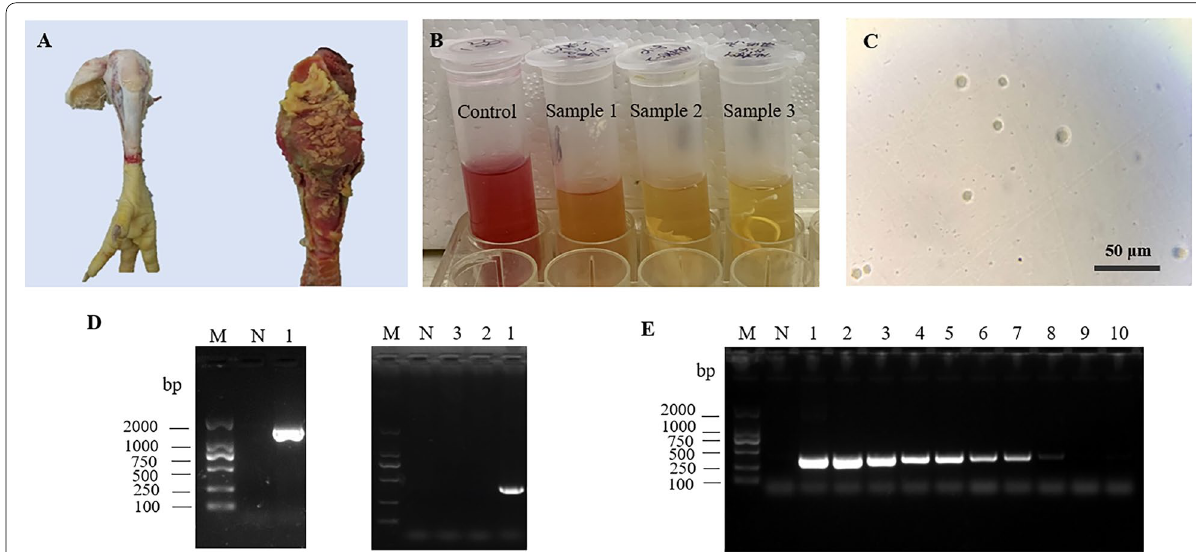
Fig. 1 Isolation and identification of M. synoviae . A Treatment of suspected diseased chicken tarsal joint; B Culture of isolates; C Colony morphology of isolated strains (40 magnification); D Specificity test; 1: MS-HB1 strain; 2: M. gallisepticum strain; 3: E. coli strain; E Susceptibility test; 1-10: × dilutions from 10 -1 to 10 -10 . M: DL2000 DNA Marker (Tsingke Biotechnology Co., Ltd., Beijing, China). vlh A gene product fragment size: 392 bp; 16S rDNA product fragment size: 1500